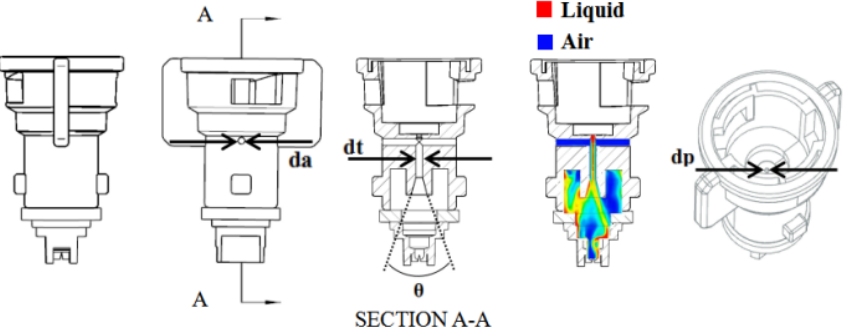
Figure 5. Simulation model of TD-ST type AIN with key geometric ruler. Note: The controlled design parameters are air inlet diameter ( da ), liquid inlet throat diameter ( dt ), pre-orifice diameter ( dp ), and Venturi angle ( θ ).